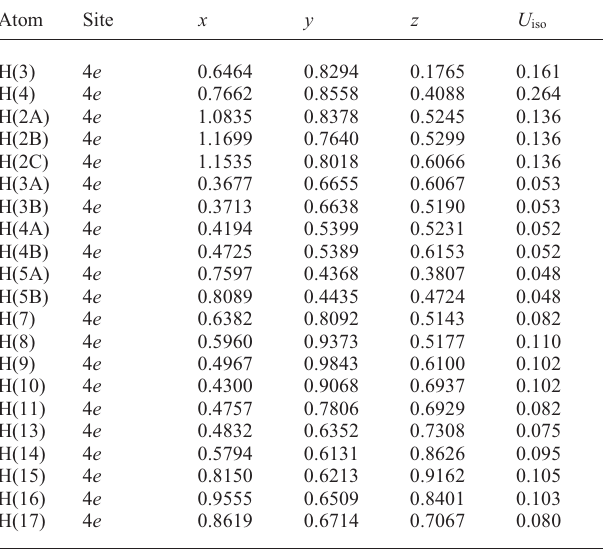
Table 2. Atomic coordinates and displacement parameters (in Å 2 )